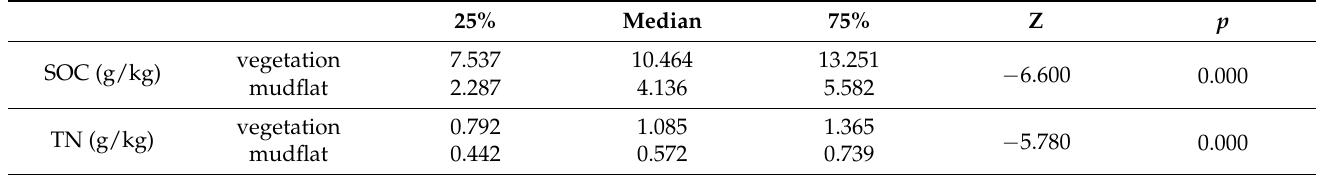
Table 2. Results of Mann–Whitney U test of SOC and TN contents under different land over types.